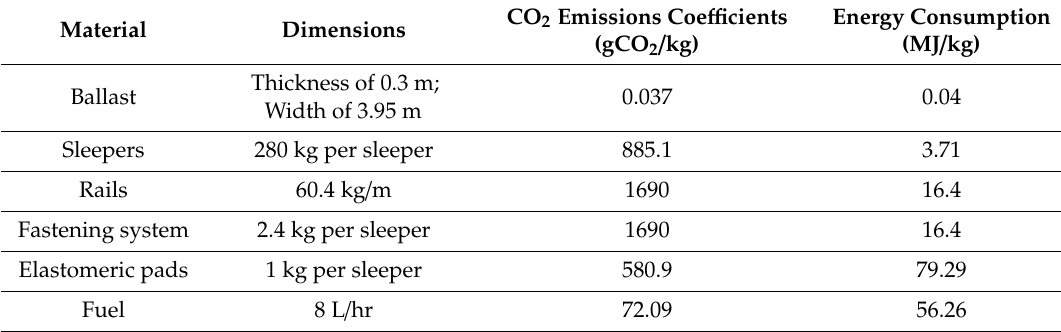
Table 8. Material characteristics for rail construction.